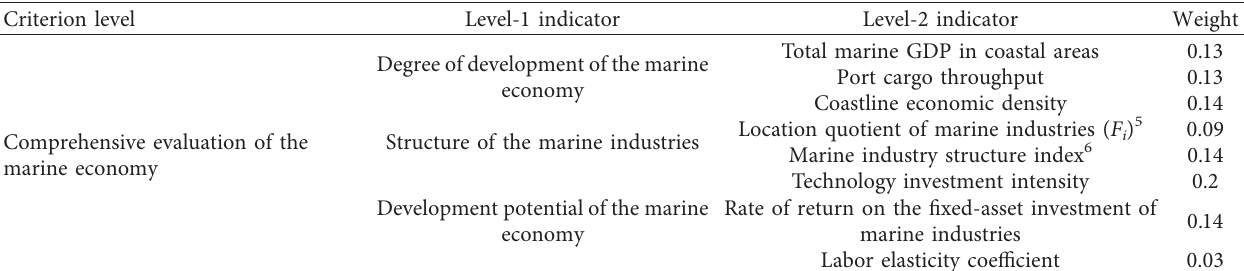
Table 3: Comprehensive evaluation indicator system for the marine economy.